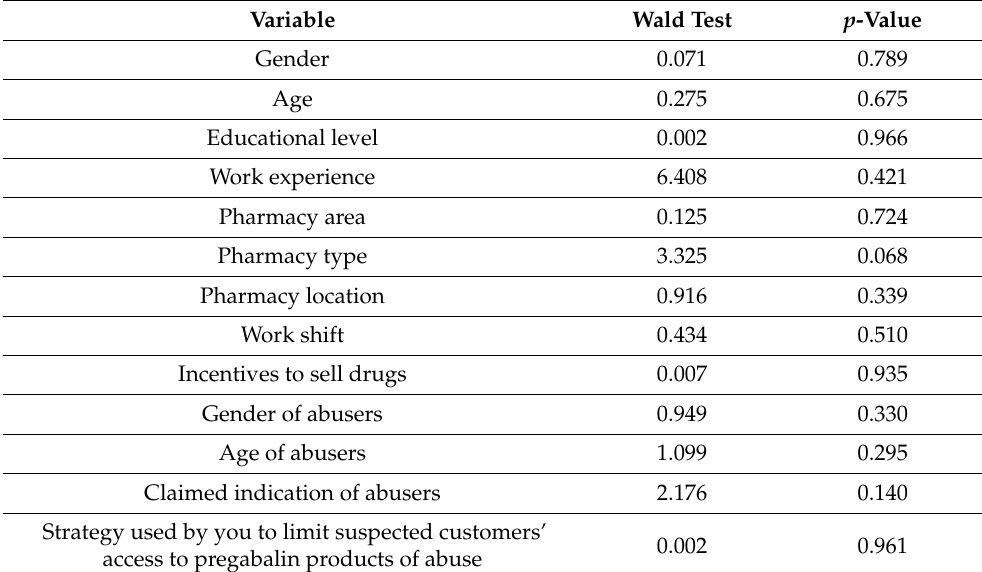
Figure 1. Perceived change of pregabalin misuse and abuse in the Aseer region ( n = 206). Table 3. Bivariate logistic regression analysis for the perceived change in pregabalin abuse during the last year.